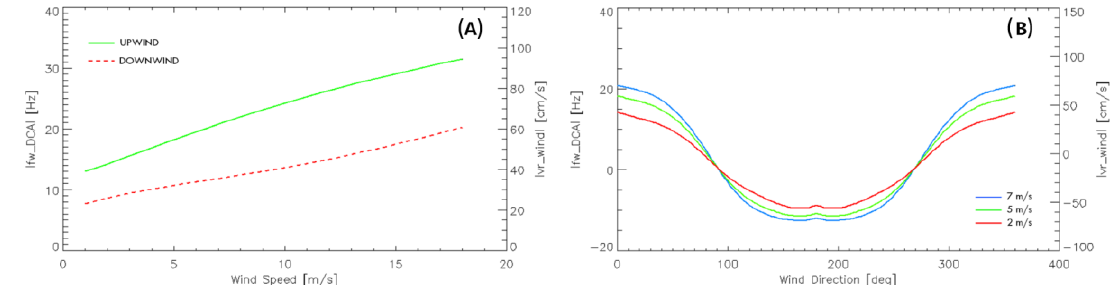
Figure 3. Plots relevant to the Doppler Geophysical Mapping Function describing the Doppler Centroid Anomaly (DCA) in Equations (18)–(22) as a function of the wind speed and direction. ( A ) modulus of the DCA ( f W _ DCA ) as a function of wind speed, for 23 ◦ of incidence angle and for VV polarization: upwind condition in green, downwind condition in red dashed. ( B ) DCA ( f W _ DCA ) as a function of the wind direction, same incidence angle polarization as in the left image, for three di ff erent wind speed values: 7 m / s (blue line), 5 m / s (green line), 2 m / s (red